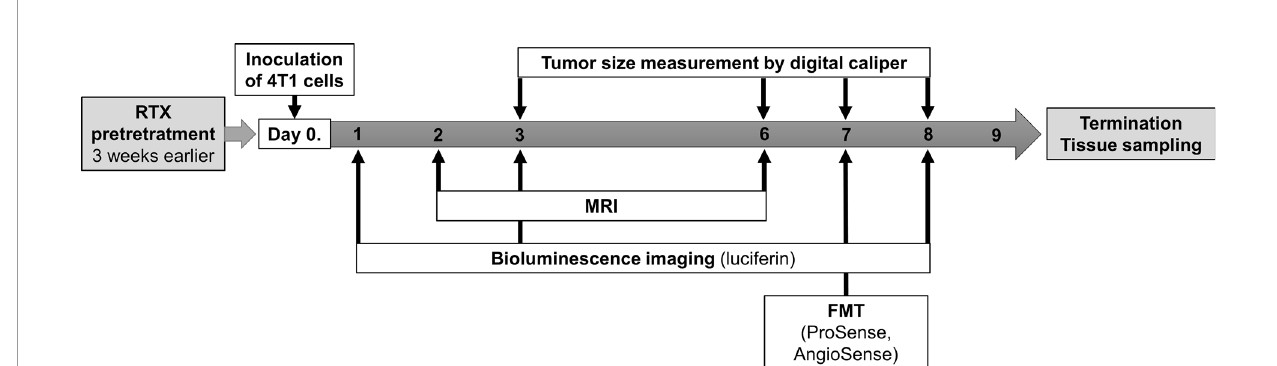
FIGURE 1 | Summary of the experimental design and timeline including the timing of the resiniferatoxin (RTX) pretreatment, inoculation of tumor cells (4T1), tumor size measurements by caliper, MRI, as well as in vivo luminescence and fl uorescence imaging by IVIS and